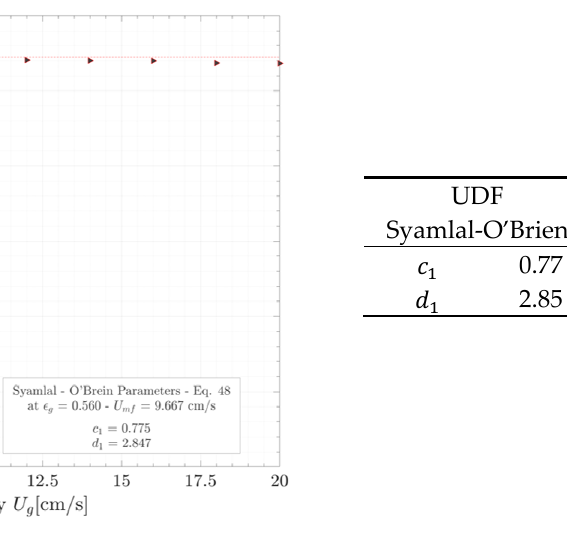
Figure 8. Pressure drop through the bed as function of the superficial gas velocity: comparison between theoretical pressure drop (red dashed line) and CFD calculation (black triangle). CFD calculations were obtained by implementing the parametric model of Syamlal-O’Brien: parameters of this model are shown in the table.